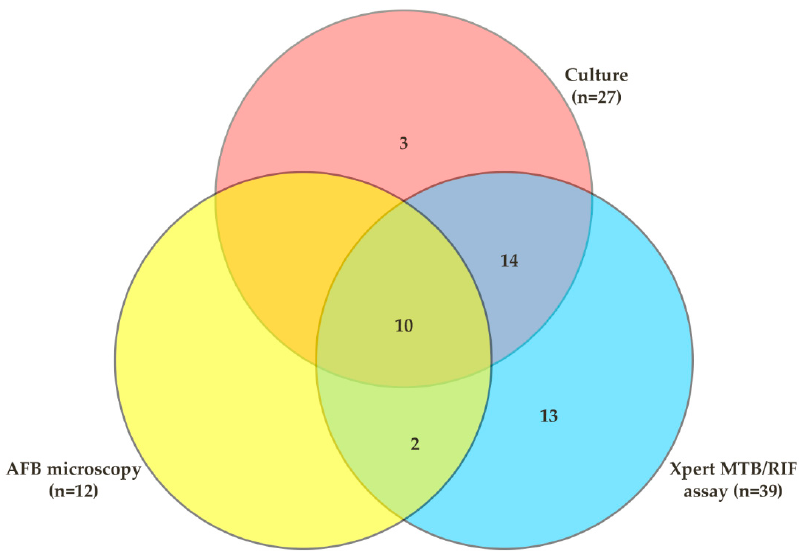
Figure 2. Venn diagram representing the positive diagnostic results of different test methods. Table 3. Comparison of sensitivity, specificity and predictive values of different test methods ac-